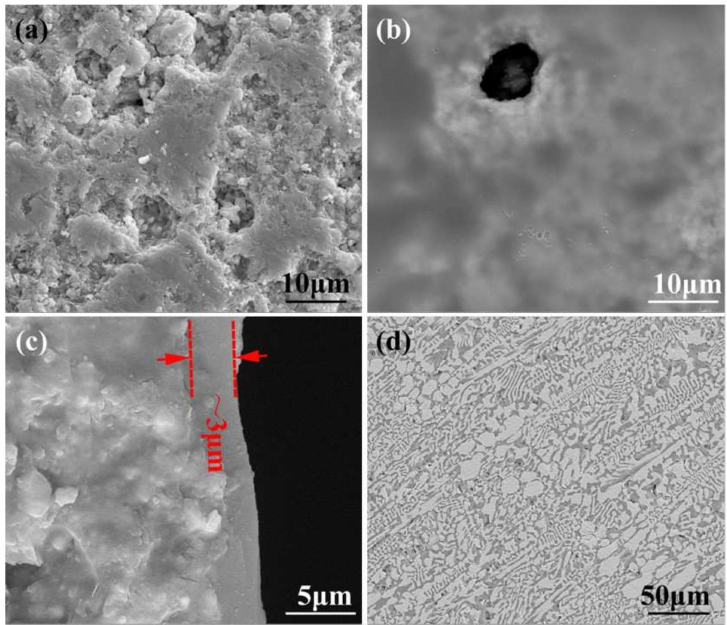
Figure 1. SEM micrographs of the reference ( a ) and carbon-coated ( b ) porous BN/Si 3 N 4 ceramic specimens, thickness of carbon coating ( c ), and SiCo38 alloy ( d ).